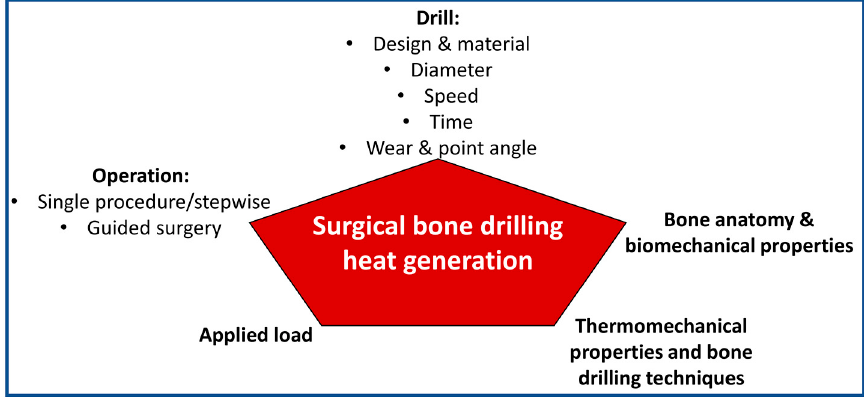
Figure 1. Heat generation factors in surgical bone drilling operations.